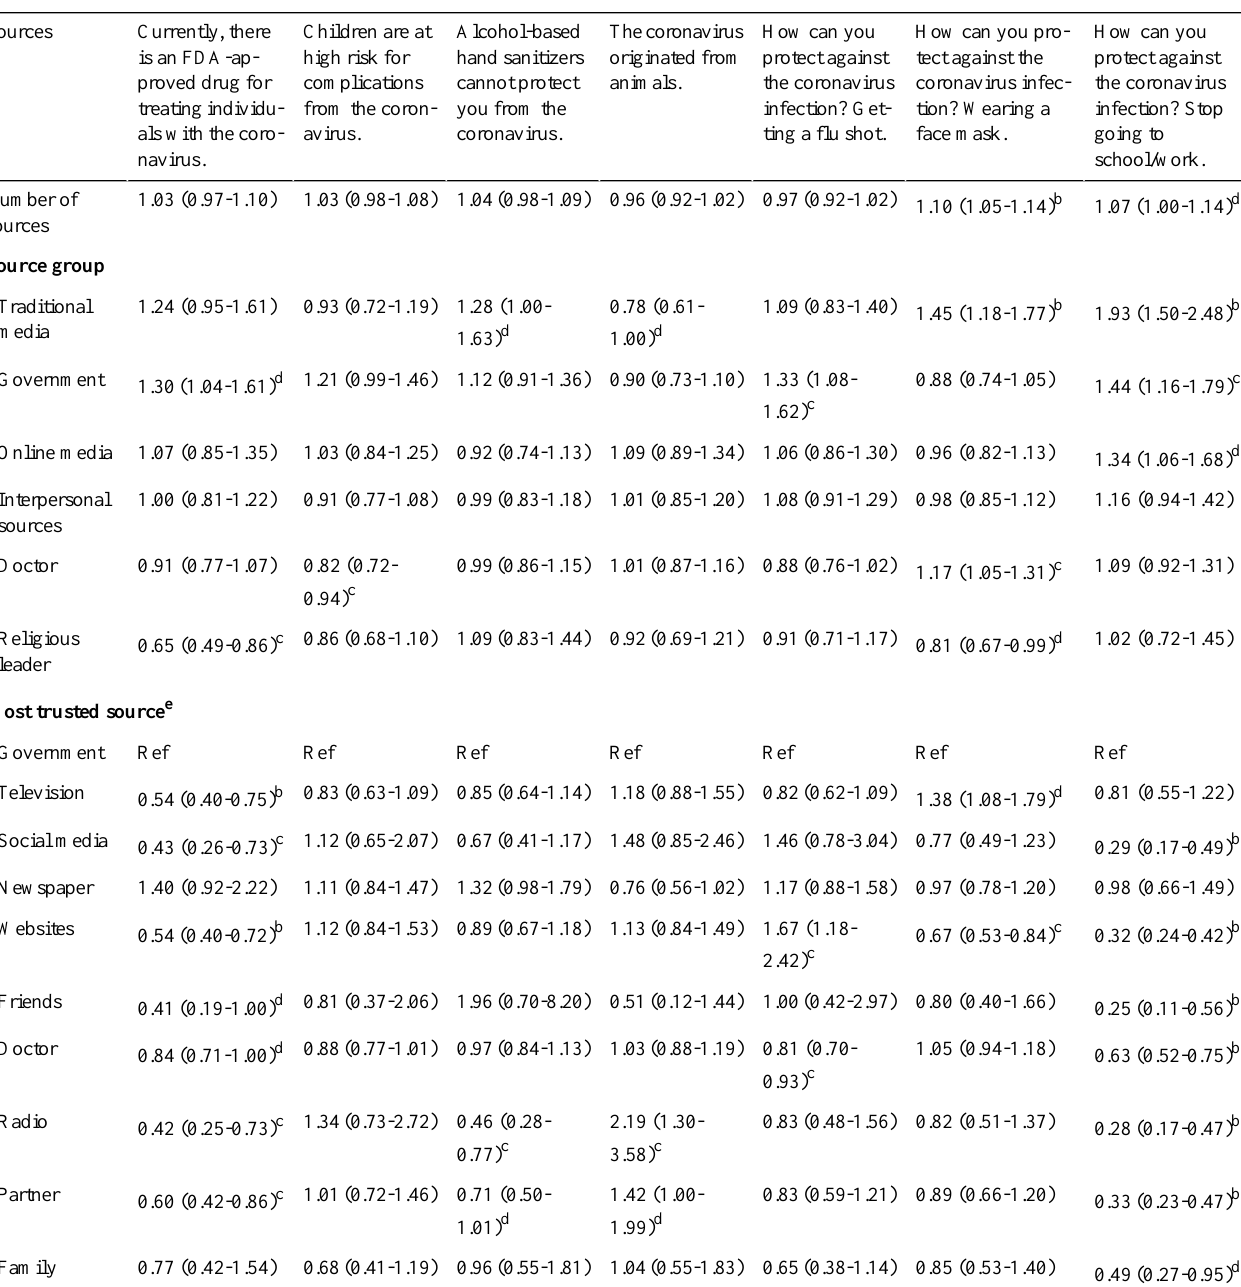
Table 3. Adjusted odds ratios (95% CI) of COVID-19 knowledge (correct answer) by information source (N=11,242) a . Ref: Reference group.